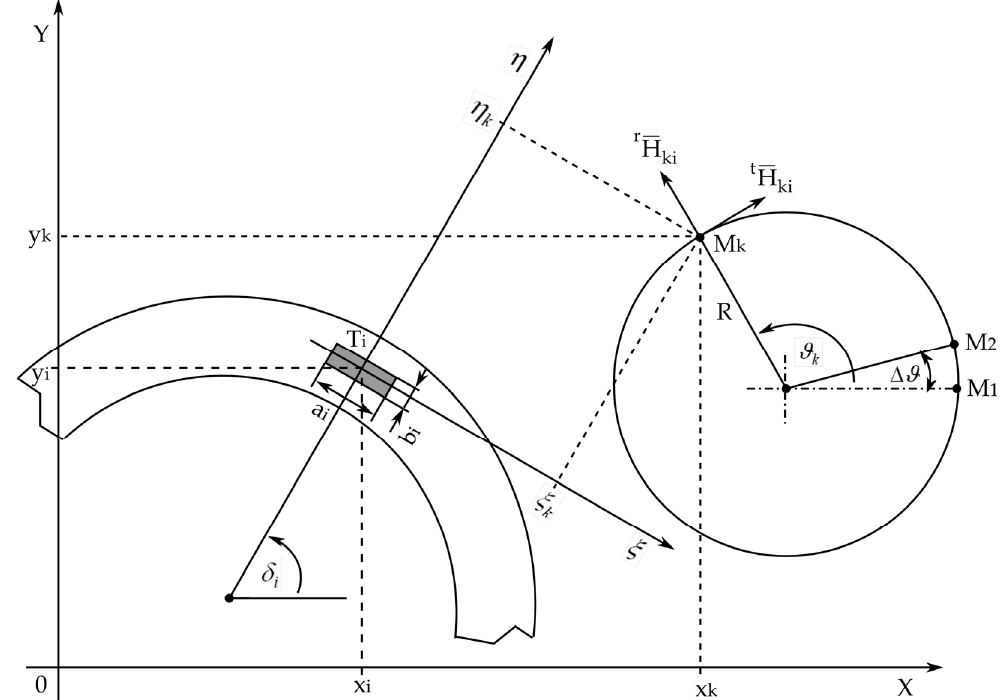
Figure 2. Geometry involved in determining the magnetic field due to current distribution in high-current